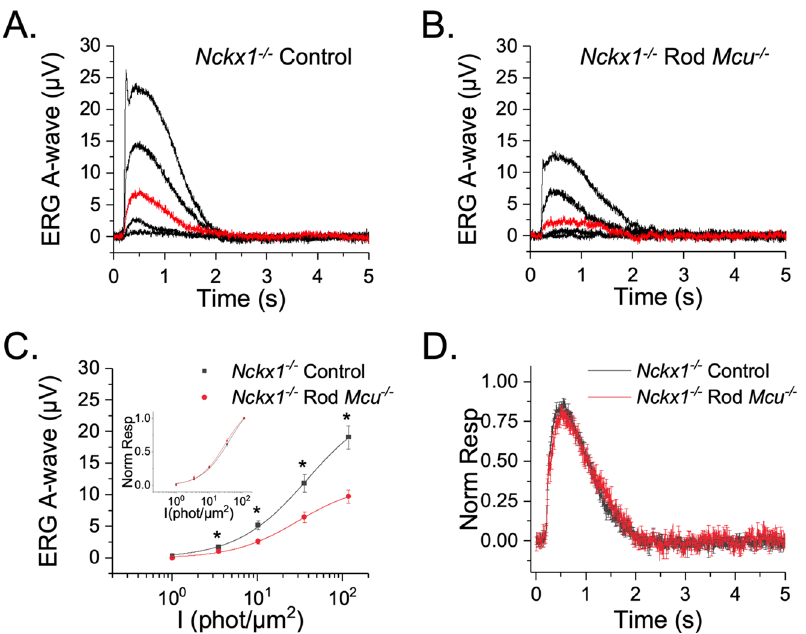
Figure 7. MCU-mediated mitochondrial Ca 2+ uptake does not modulate the photoresponses in Nckx1 -/- mice. ( A , B ) Flash response families of dark adapted Nckx1 -/- iCre + ( Nckx1 -/- control; A ) and Nckx1 -/- Mcu f/f iCre + double knockout ( Nckx1 -/- Rod Mcu -/- ; B ) mice from transretinal ERG recordings. Scotopic a-wave responses were recorded by a series of test flashes (1 ms in duration) with intensities (in photons/µm 2 ) 1, 3.5, 10.2 (red traces), 35.4, 117. ( C ) Averaged rod responses (Mean ± SEM) from Nckx1 -/- control (black; n = 10) and Nckx1 -/- Rod Mcu -/- mice (red; n = 9) plotted as a function of flash intensity show a substantial reduction of the response amplitude in the double knockouts as compared to the controls. However, the sensitivity of the rods (estimated their normalized intensity response functions; Inset) remained unchanged between Nckx1 -/- control (black) and Nckx1 -/- Rod Mcu -/- (red) mice. ( D ) The kinetics of the dim flash response were not affected in the Nckx1 -/- Rod Mcu -/- mice (n = 9); red trace) as compared to Nckx1 -/- controls (n = 10; black